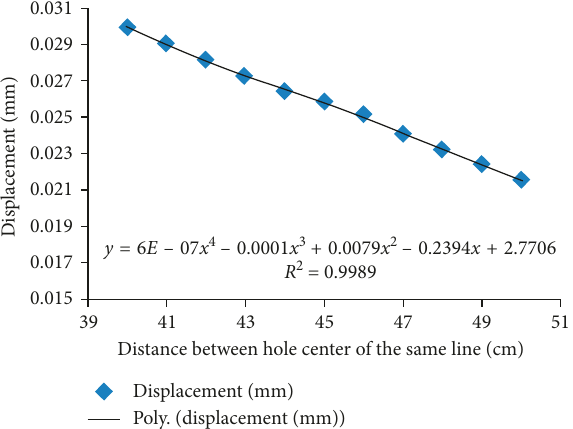
Figure 13: Maximum displacement as a function of the distance between the holes of the same line in the square mesh.